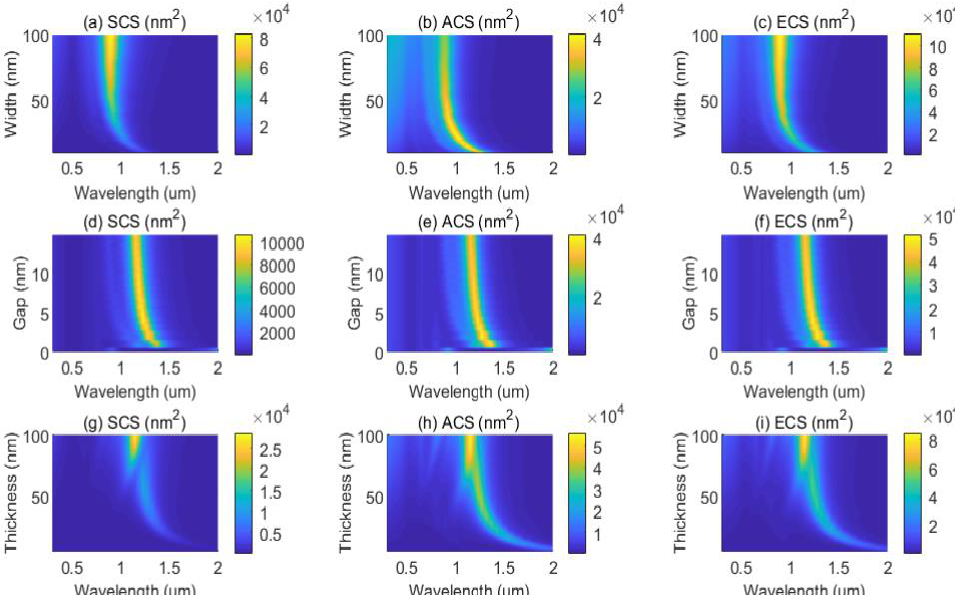
Figure 2. Scattering cross section, absorption cross section, and extinction cross section of the PGNB on a flat sapphire substrate depend on various geometrical parameters (width, gap size, and thickness of the PGNB) and the incident wavelength. The incident light source, with a wavelength range between 0.3 μm and 2 μm and a polarization angle of 90 degrees (the polarization direction was oriented at the y -axis), was illuminated on the PGNB vertically. ( a – c ): the scattering cross section, absorption cross section, and extinction cross section of the PGNB depend on the width of the nanobowtie and the incident wavelength; ( d – f ): the scattering cross section, absorption cross section, and extinction cross section of the PGNB depend on the gap size between each gold nanoparticle and the incident wavelength; ( g – i ): the scattering cross section, absorption cross section, and extinction cross section of the PGNB depend on the thickness of the nanobowtie and incident wavelength.